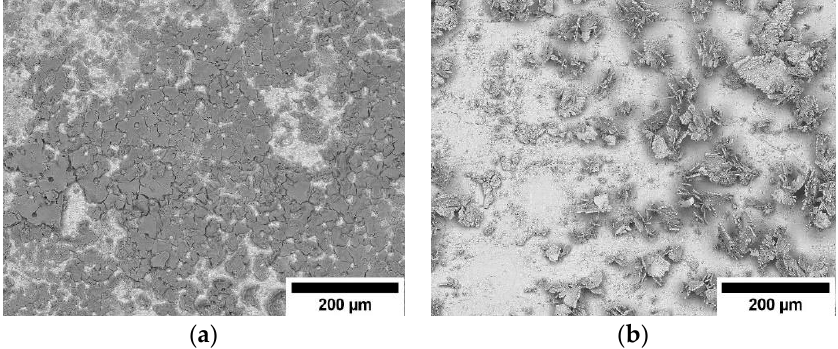
Figure 1. SEM images of Co coatings deposited under galvanostatic conditions, at cathodic current density j = 2.5 A/cm², deposition time t = 60 s . The composition of solutions: ( a ) 0.2 M CoCl 2 ; ( b ) 0.2 M CoSO 4 .